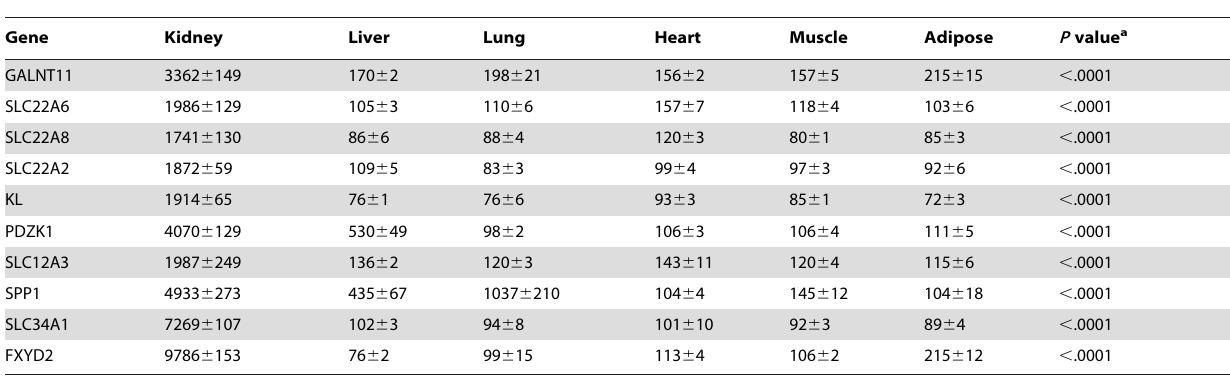
Table 3. Mouse kidney-specific gene expression values.